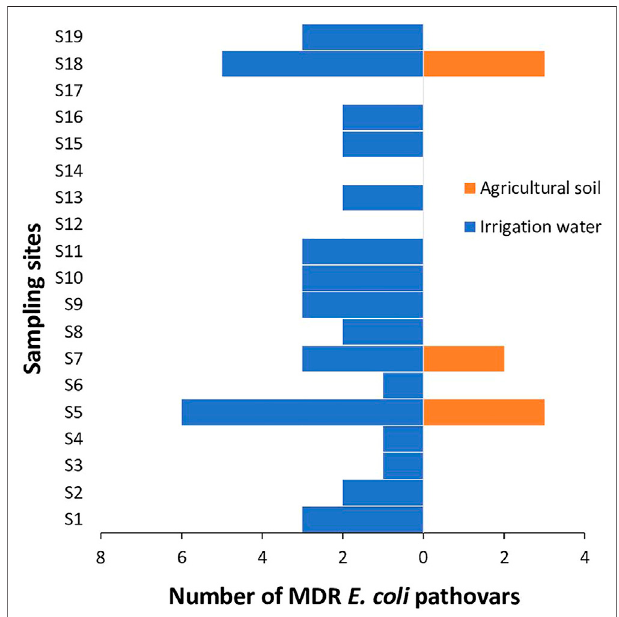
FIGURE 4 | The distribution of MDR pathogenic strains of E. coli in irrigation water and agricultural soil across the sampling sites.